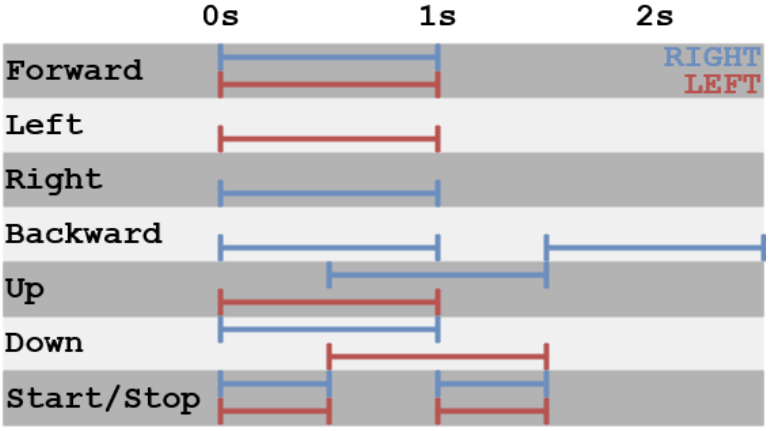
Figure 5. The signals the two vibration motors, left and right, use to guide the user along the route during the navigation procedure.